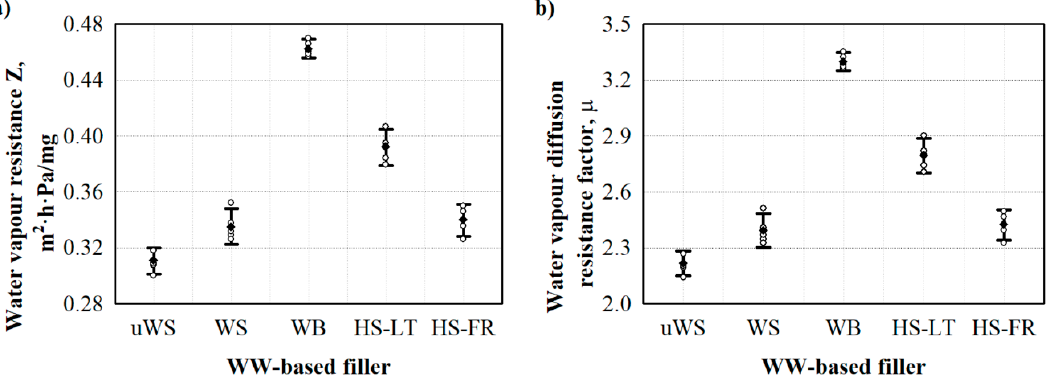
Figure 4. Water vapour permeability parameters of WW-based fillers: ( a ) water vapour resistance and ( b ) water vapour diffusion resistance factor. uWS—uncleaned sawdust, WS—cleaned sawdust, WB— wood bark, HS-LT—Lithuanian hemp shivs, HS-FR—French hemp shivs, ο —single values from water vapour parameters measurements, ● —average value from water vapour parameters measurements.